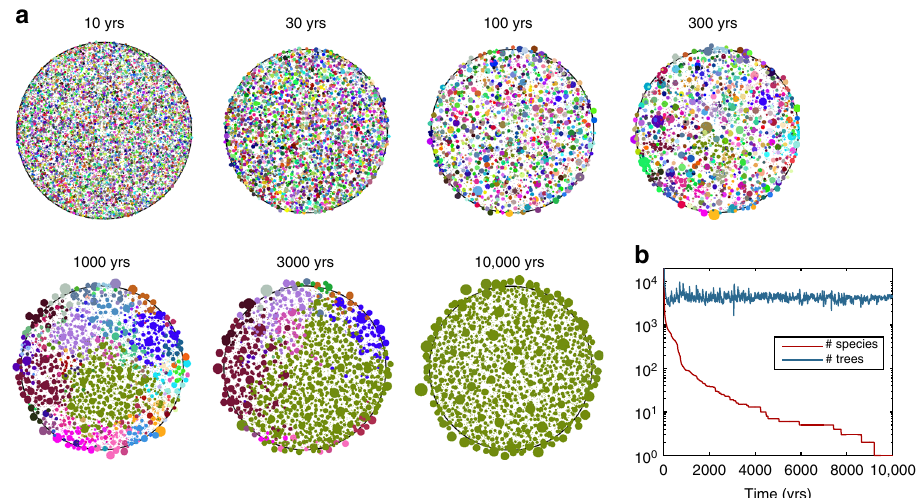
Fig. 2 Evolution of a forest on a virtual island. a Example of the evolution of a virtual forest over 10,000 yrs (Supplementary Movie 1). Initially, 20,000 trees with random genomes are sown. Each circle is a tree whose centre is at the centre of gravity of foliages, and whose radius is the standard deviation of the foliage distribution projected onto the ground. The outer black circle of radius R = 200 L is the habitat limit. Colours are determined using three neutral marker genes as RGB values. Because trees growing at the periphery are on average larger than the others, allometric statistics (see below) are performed on trees with their trunk in a central zone of radius 0.9 R . b Number of trees and number of species as a function of time, for the same forest as in